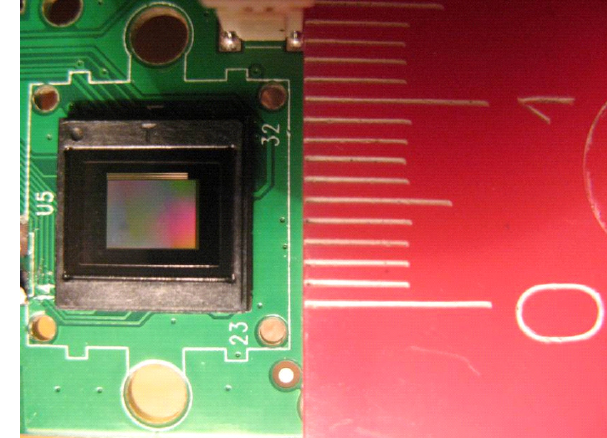
Figure 4: Determination of physical sizes of an optical sensor pixel using a ruler and a digital camera.